Question: Condense the content of this figure into a single sentence.
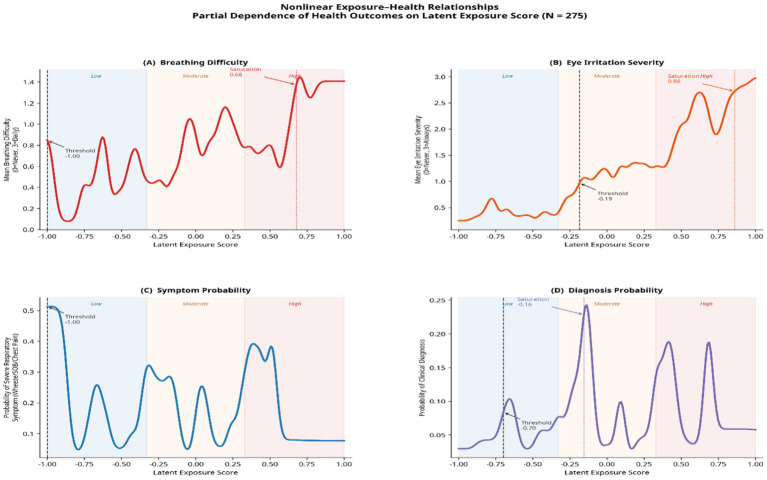
Answer: Nonlinear Exposure–Health Relationships. (A) Partial dependence of breathing difficulty on latent exposure score. (B) Partial dependence of eye irritation severity on latent exposure score. (C) Partial dependence of severe respiratory symptom probability on latent exposure score. (D) Partial dependence of clinical diagnosis probability on latent exposure score.